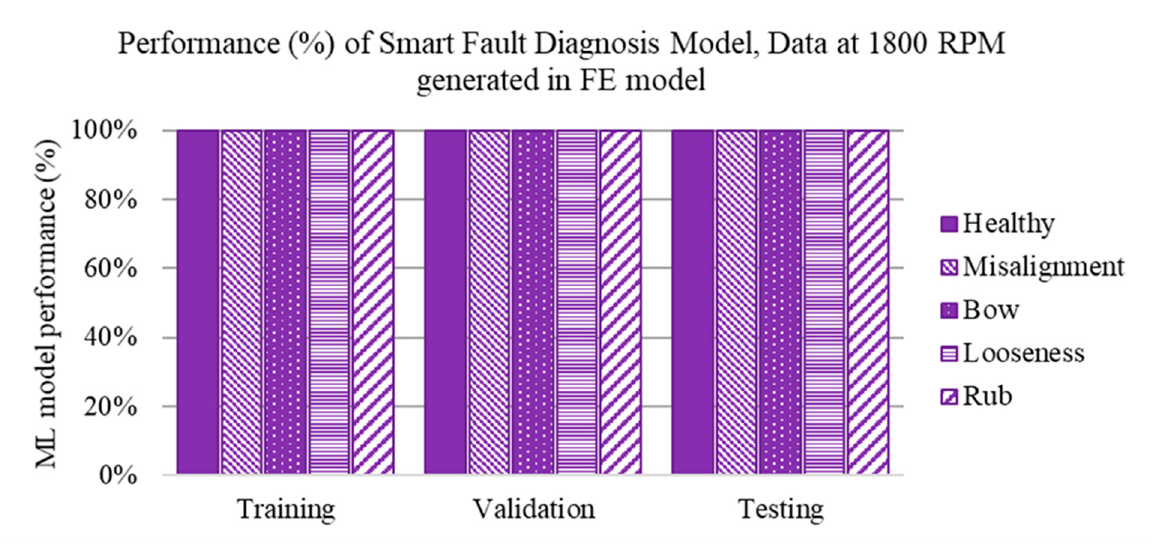
Figure 9. Performance (%) of VML fault diagnosis model, using only data generated at 1800 RPM in the FE model.